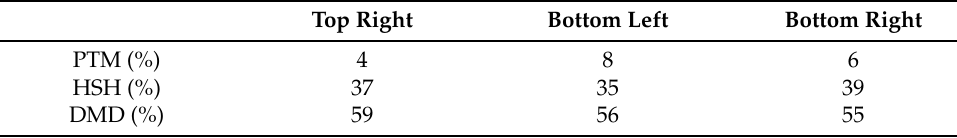
Table 1. Participants’ preferred choices per reconstruction model and screen zone. Top Right Bottom